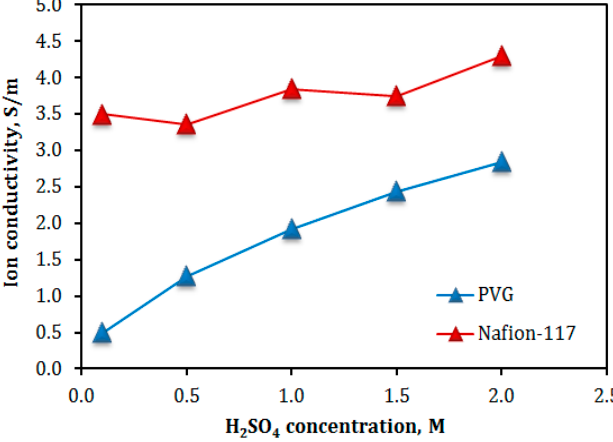
Figure 9. Ion conductivity in the VPG and Nafion membranes as a function of H 2 SO 4 concentrations.